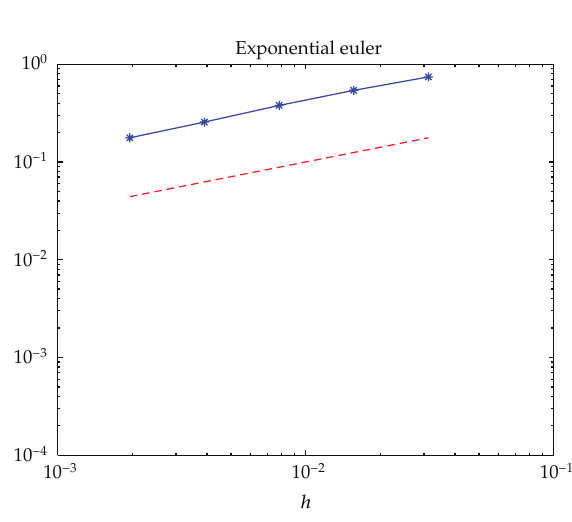
Figure 1: Numerical approximation for strong convergence order of exponential Euler